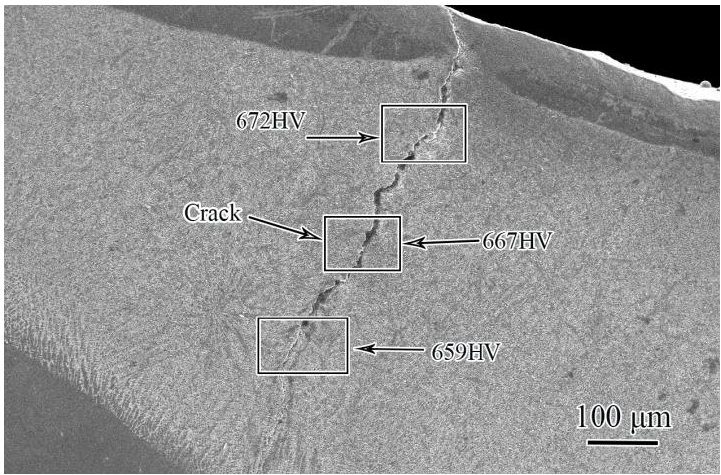
Figure 10. High hardness TiB 2 /TiB cladding layer.